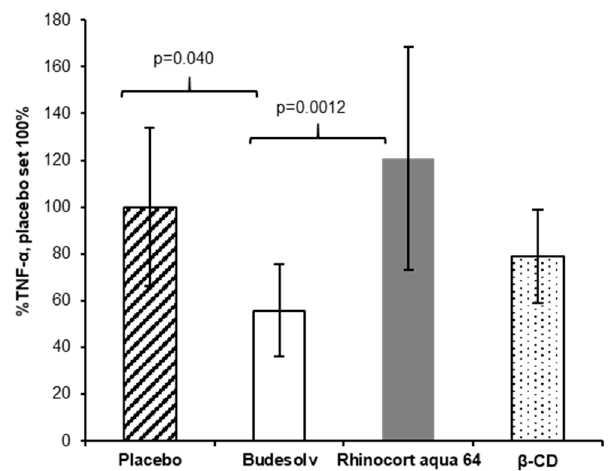
Figure 5. In vivo TNF- α quantification in a therapeutic set-up. Determined concentrations of TNF- α ( y -axis, normalized to Placebo) in murine BAL after intranasal treatment with either Budesolv 300 µg/mL, Rhinocort ® aqua 64 (1.28 mg/mL dispersed budesonide), a β -CD formulation containing 300 µg/mL solubilized budesonide, or Placebo ( x -axis) done 15 min after LPS challenge. Data are expressed as mean ± SD ( n = 5). Statistical analysis was done by One-way ANOVA with Bonferroni’s post-test.